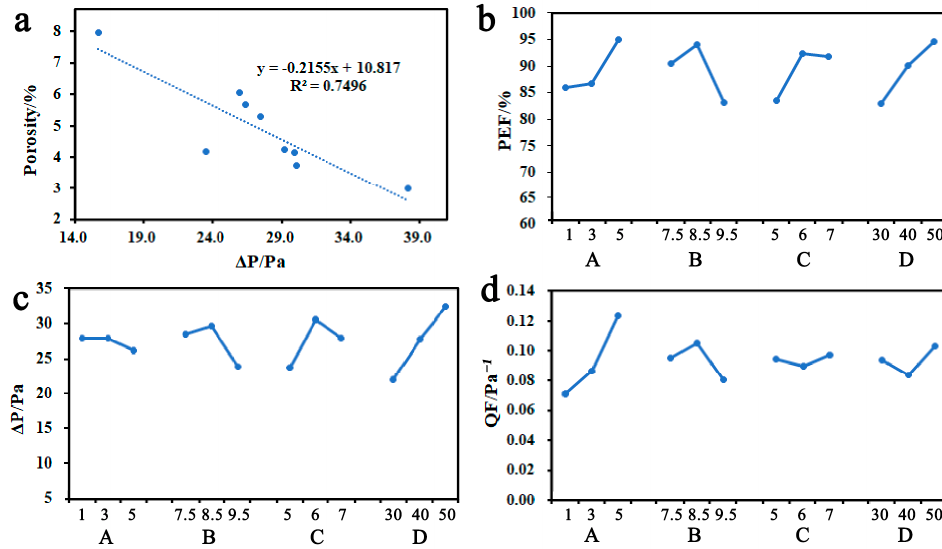
Figure 4. ( a ) The linear relationship between ∆ p and porosity; the results of the analysis of the orthogonal four factors with PFE ( b ), ∆ p ( c ), and QF ( d ), respectively.